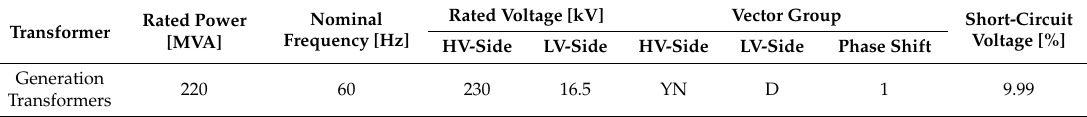
Table A3. Electrical parameters for the network transformers used in the sample power system. Transformer